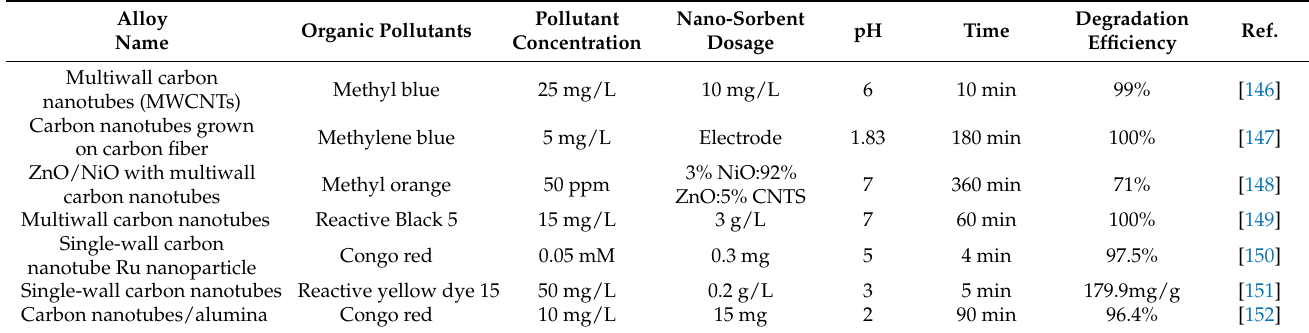
Table 5. Azo dye degradation with carbon nanotube materials.